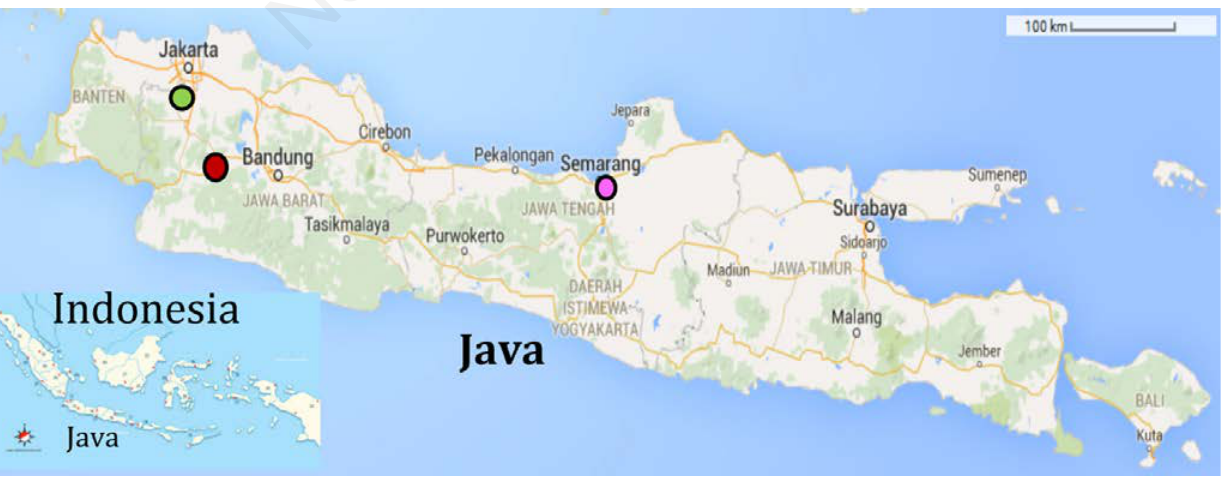
Figure 1. Sampling sites in Java island: green, Bogor; red, Sukabumi; violet, Semarang (insert =